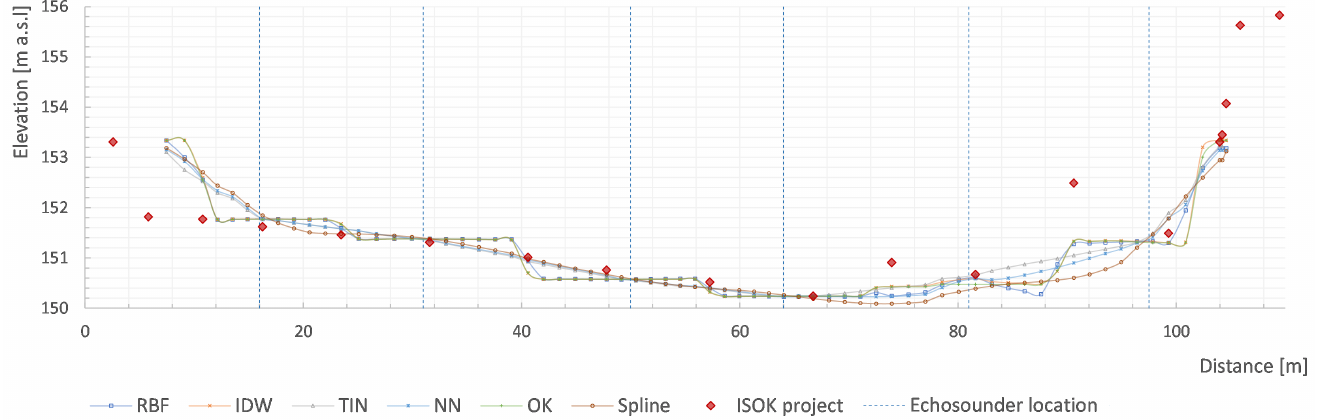
Figure 10. Cross-section of the km 141 + 500. Cross-section B (XS B) displayed in Figure 3.